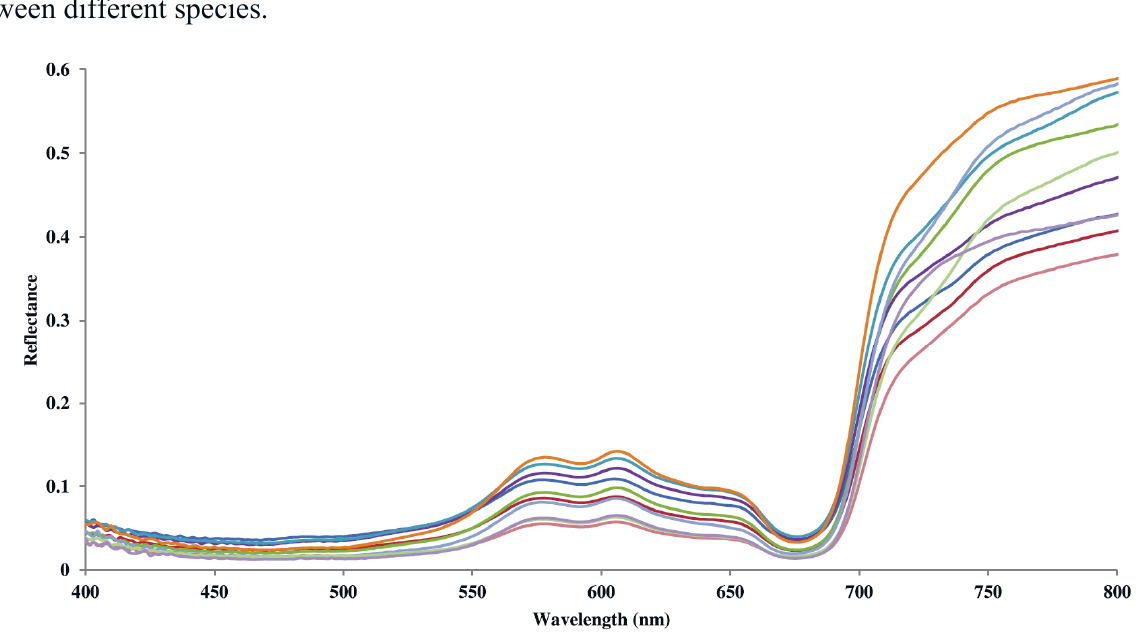
Figure 3. Representative individual spectra measured for Acropora palmata ; examples shown here are 10 spectra subset from a total sample size = 139 spectra.